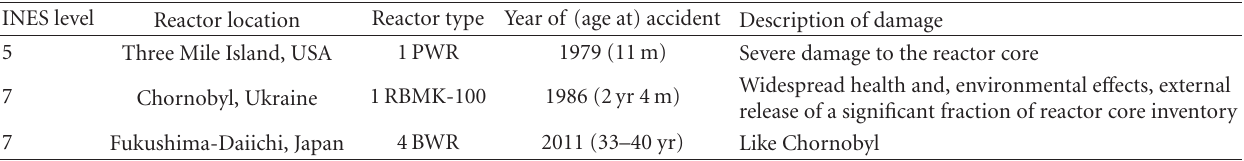
Table 1: NPP reactor accidents with INES level ≥ 5, reactor age denotes time since grid